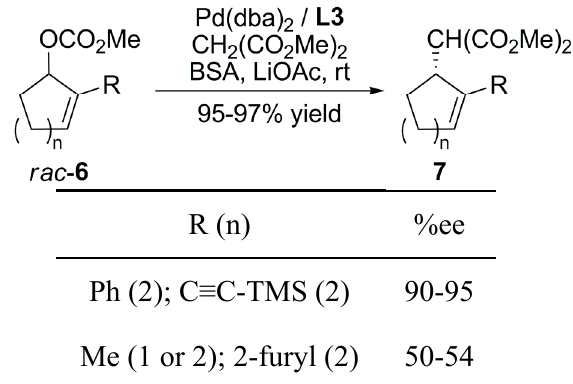
Table 1. Asymmetric allylic alkylation reaction with L3